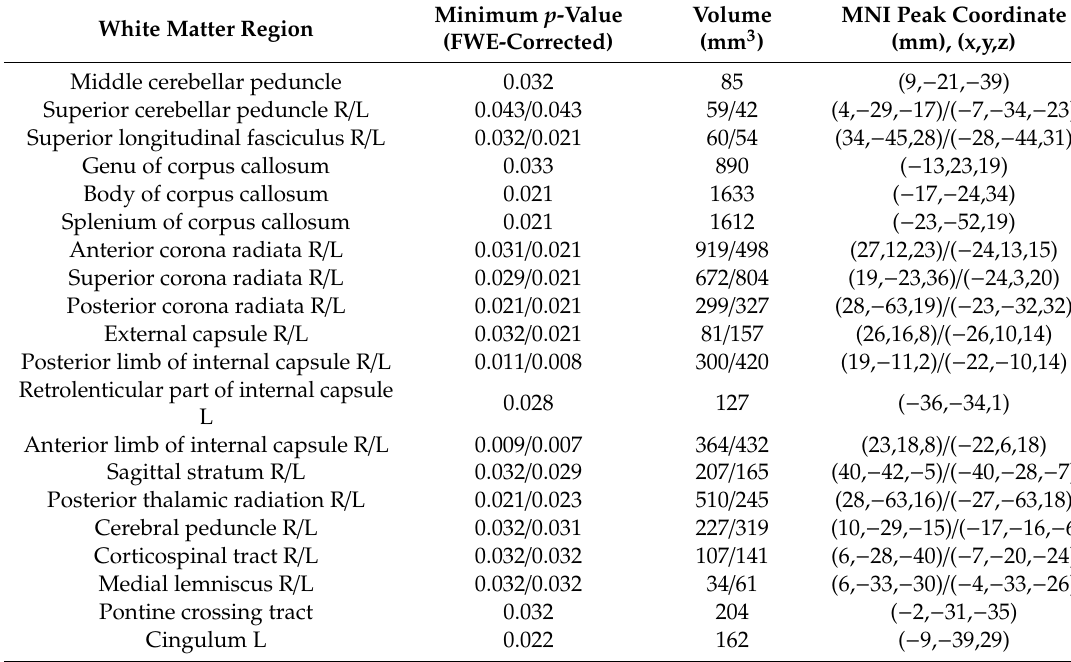
FWE = Family-wise error; L = left; R = right. The column volume represents the volume from the atlas region with significant results. No regions with a volume equal or lower than 30 mm 3 were included in this table. Table A11. White matter regions from the ICBM-DTI-81 White Matter Atlas for which significant increased RTAP values were found in CM compared to EM including the duration of the migraine, presence of aura and medication overuse headache as